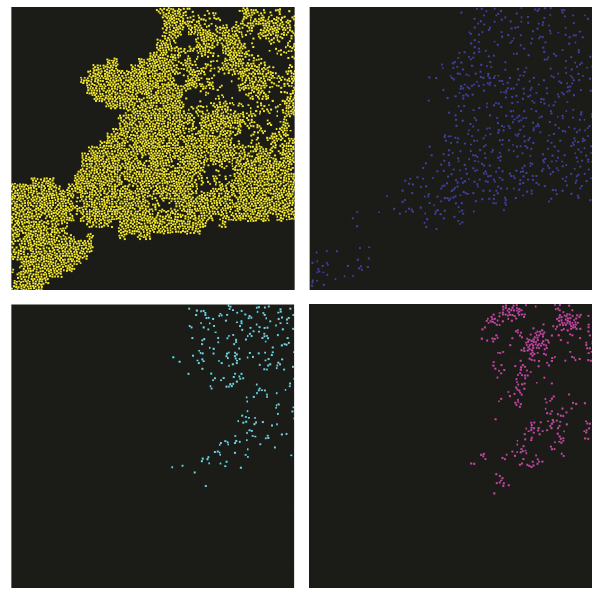
Figure 8: The intermediate result in the classification process where each plant species has been assigned to the available plant positions separately to meet the coverage input